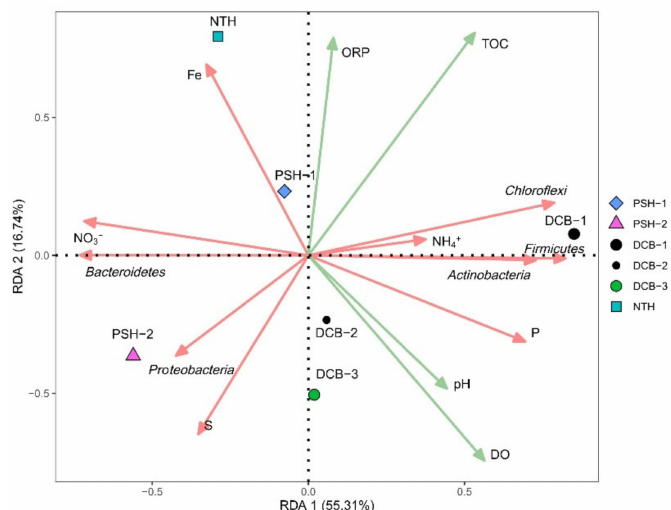
Figure 6. Redundancy analysis plot of the relationship among bacteria and dominant environmental parameters in sediment. Green solid lines indicate major environmental variables. Red solid lines show elements measured in sediments and the top five bacteria in relative abundance at the phylum level. Geometric graphs represent the sampling